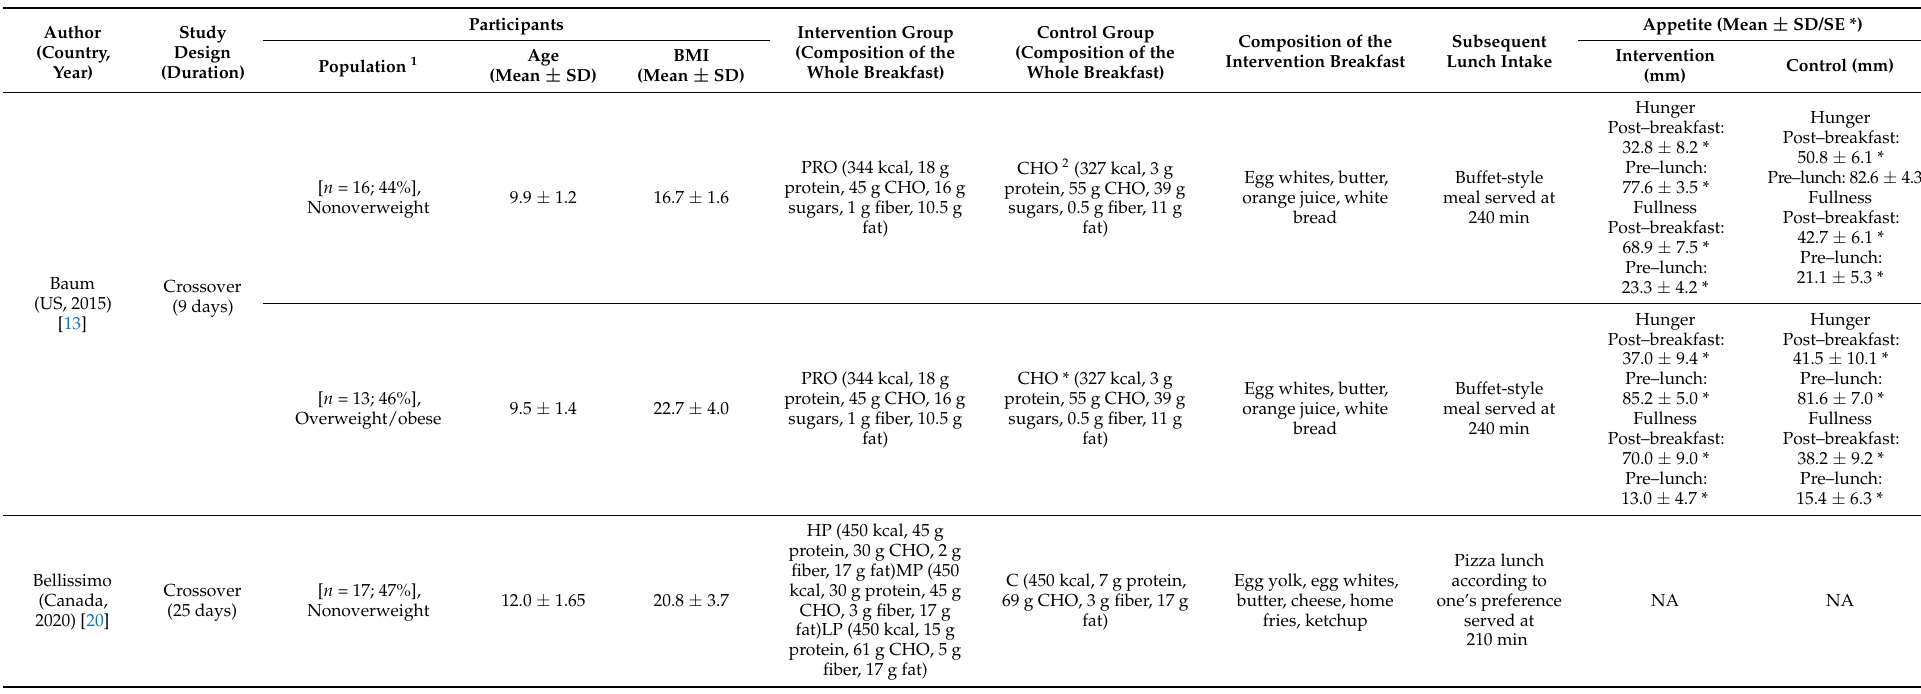
Table 3. Characteristics of included studies in the systematic